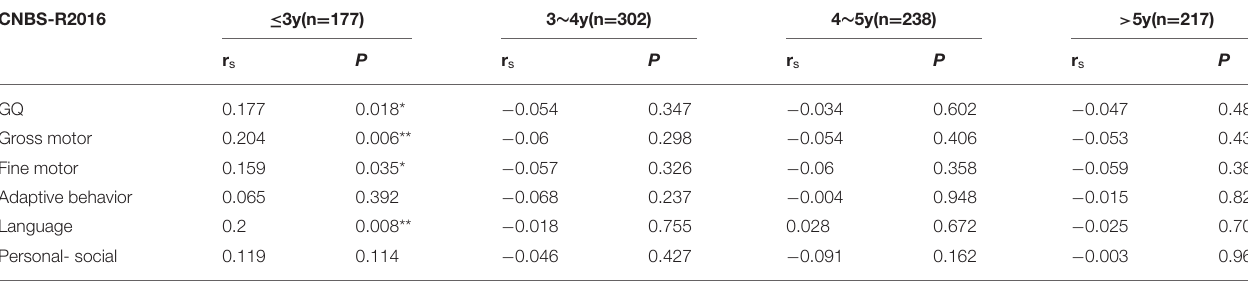
TABLE 4 | Effect of serum folate levels on CNBS-R2016 scores in the ASD children at different age groups. CNBS-R2016